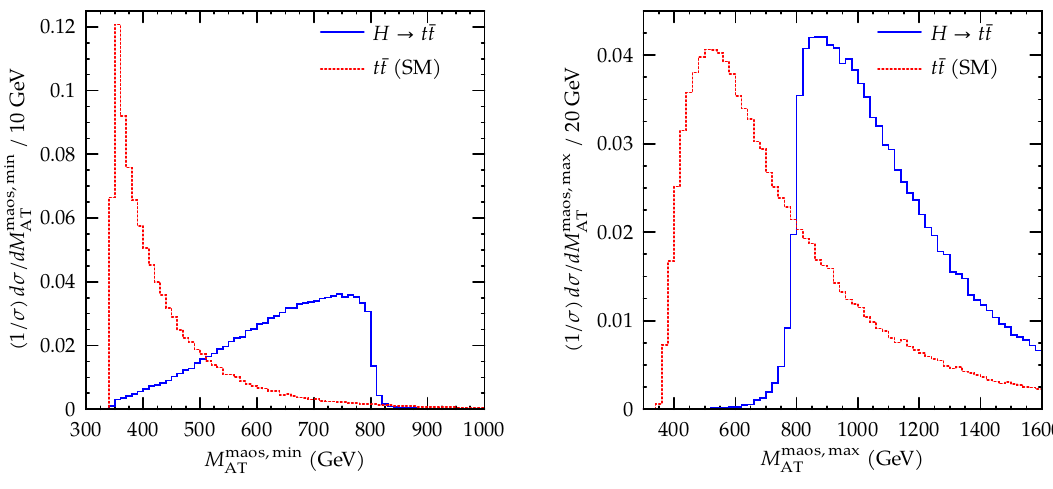
Figure 5 . The M maos distributions for the H ! t (cid:22) t signal and the SM t (cid:22) t background at parton AT